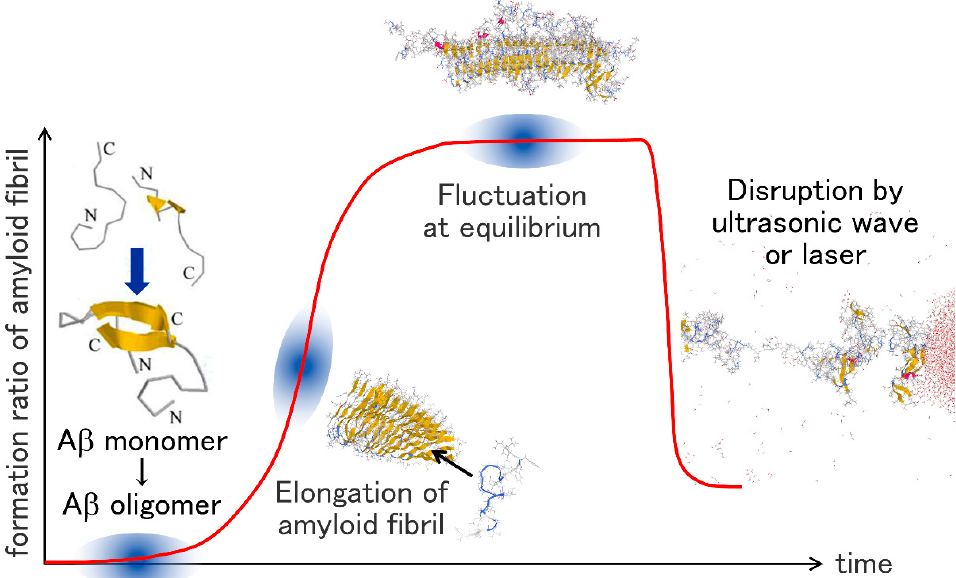
Figure 1. Schematic illustration of oligomerization of A β peptides, elongation of the A β amyloid fibril, the A β amyloid fibril in equilibrium, and disruption of the A β amyloid fibril.